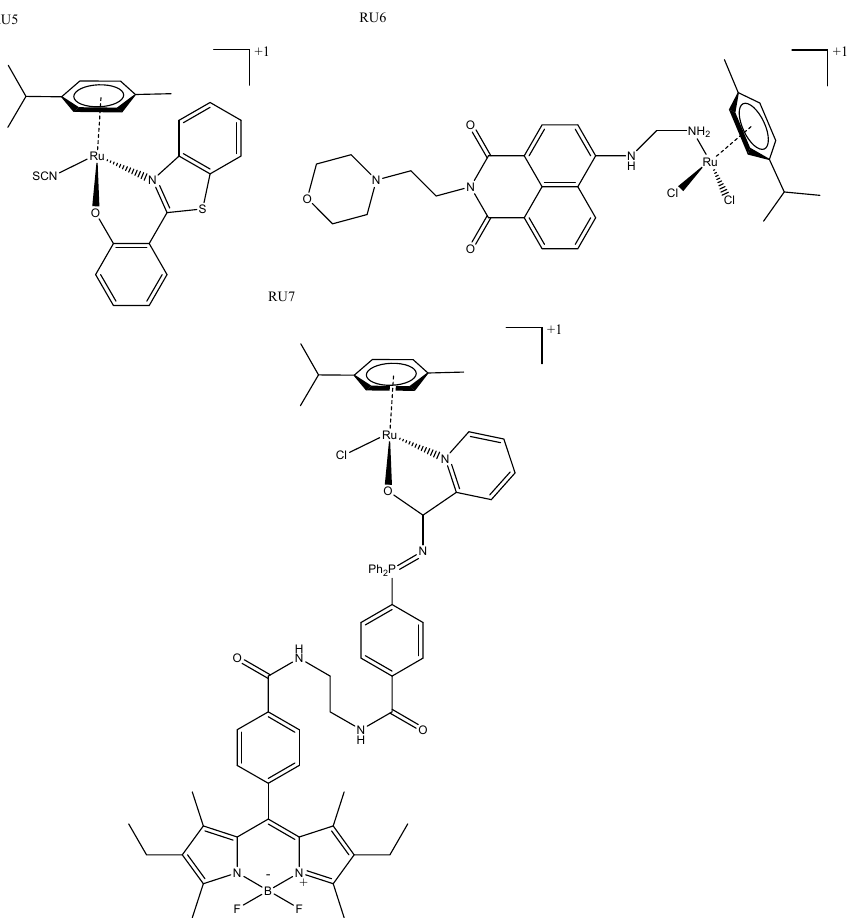
Figure 6. Ruthenium piano stool complexes RU5 [56], RU6 [57], and RU7 [58].